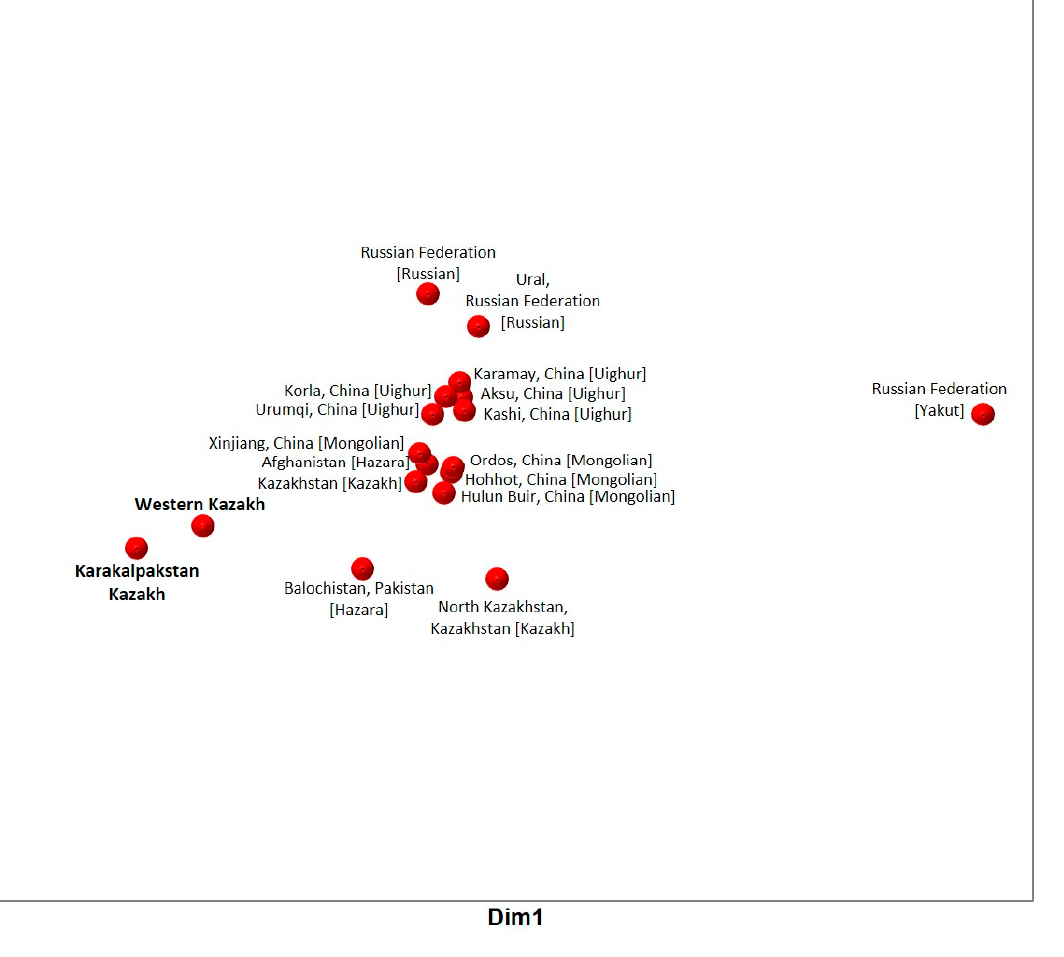
Figure 1. MDS plot based on R ST genetic distances between our samples and the neighboring populations based on 23 Y-STRs (stress = 0.074). Table 2. Comparison of forensic parameters among Kazakh tribes based on 27 Y-STR